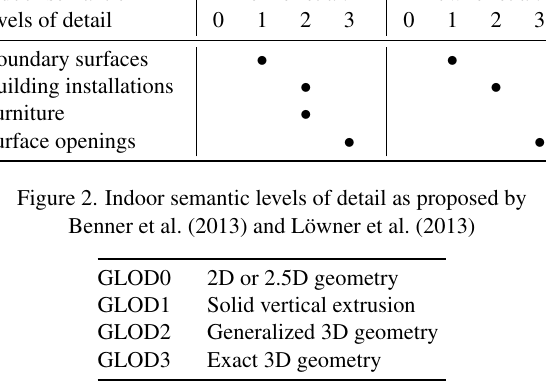
Table 4. Geometric levels of detail as proposed